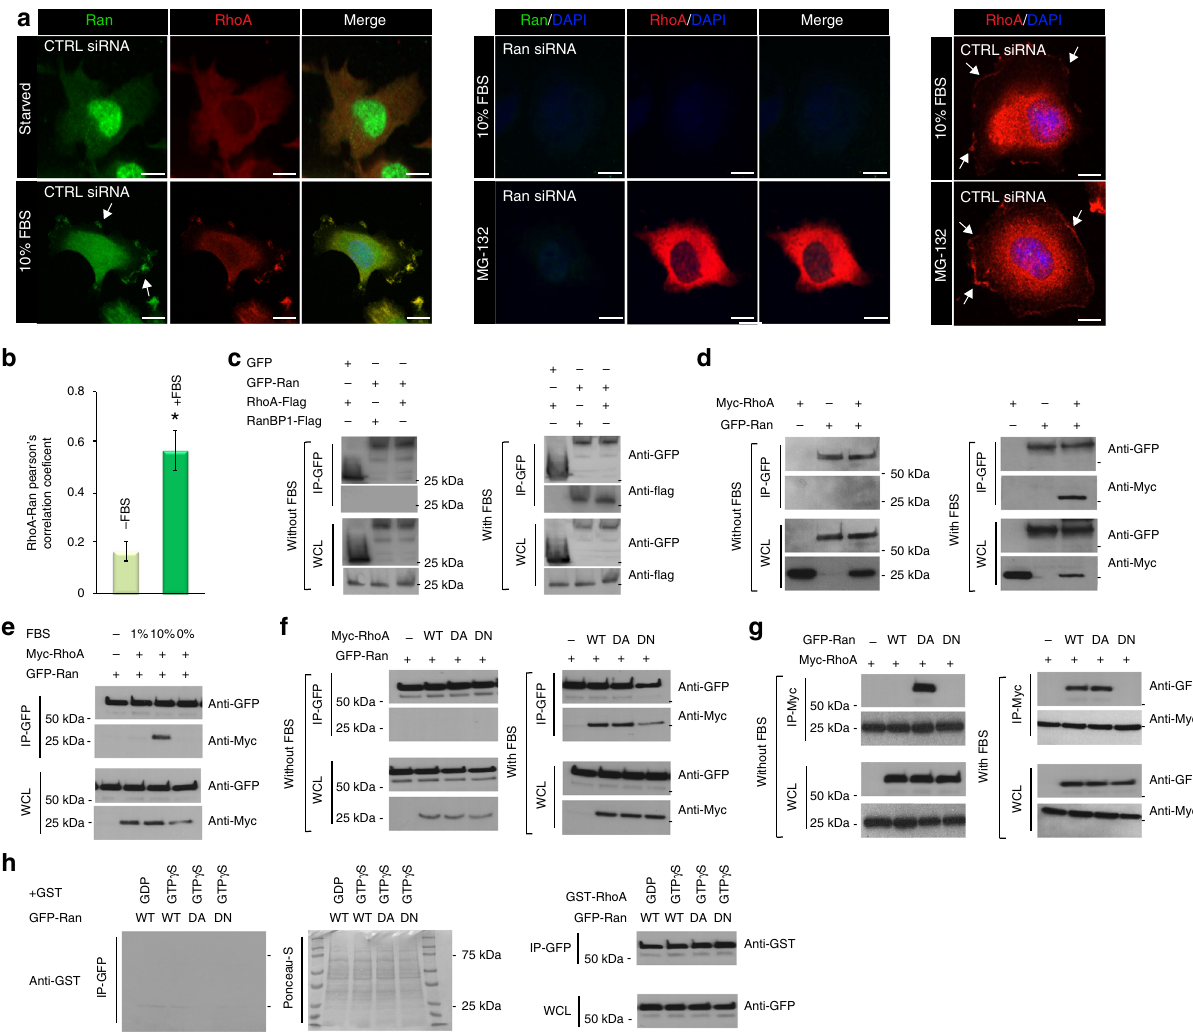
Fig. 2 Ran GTPase promotes RhoA recruitment to the plasma membrane by direct interaction. a TOV-112D cells were either starved or incubated with 10% FBS, treated with or without 20 µ M MG-132 for 2 h, and transfected with CTRL or Ran siRNA as indicated. Cells were then fi xed, permeabilized, and subjected to immuno fl uorescence using Ran and RhoA antibodies and DAPI (Merge). Cells were visualized by spinning disk microscopy. Arrows show Ran and RhoA colocalization at the plasma membrane. Scale bars, 10 µ m. b Colocalization between RhoA (red) and Ran (green) was represented as Pearson ’ s correlation coef fi cient and measured in individual TOV-112D starved cells or with 10% FBS. All values are means ± SEM from three independent experiments. P -values are based on comparisons with CTRL using the t test: * P < 0.05 was considered statistically signi fi cant. c TOV-112D cells co- transfected with RanBP1-Flag or RhoA-Flag and GFP alone or 2xGFP-Ran (WT) were starved or incubated with 10% FBS, as indicated. Cell lysates were subjected to immunoprecipitation (IP) with an anti-GFP or an anti-Flag antibody and western blotted as shown. GFP alone was used as a negative control and RanBP1-Flag as a positive control. d – g TOV-112D cells co-transfected with Myc-RhoA (WT, DA, or DN) and 2xGFP-Ran (WT, DA, or DN) were starved or incubated with 1% or 10% FBS, as indicated. Cell lysates were subjected to immunoprecipitation (IP) with an anti-GFP or an anti-Myc antibody and western blotted as shown. h TOV-112D cells transfected with 2xGFP-Ran (WT, DA or DN), lysed, and subjected to IP with an anti-GFP antibody. Protein complexes were separated by SDS-PAGE and transferred to the nitrocellulose membrane. The membranes were incubated with free GST protein (negative control) or fusion protein GST-RhoA (GDP or GTP γ S) and immunoblotted with anti-GST